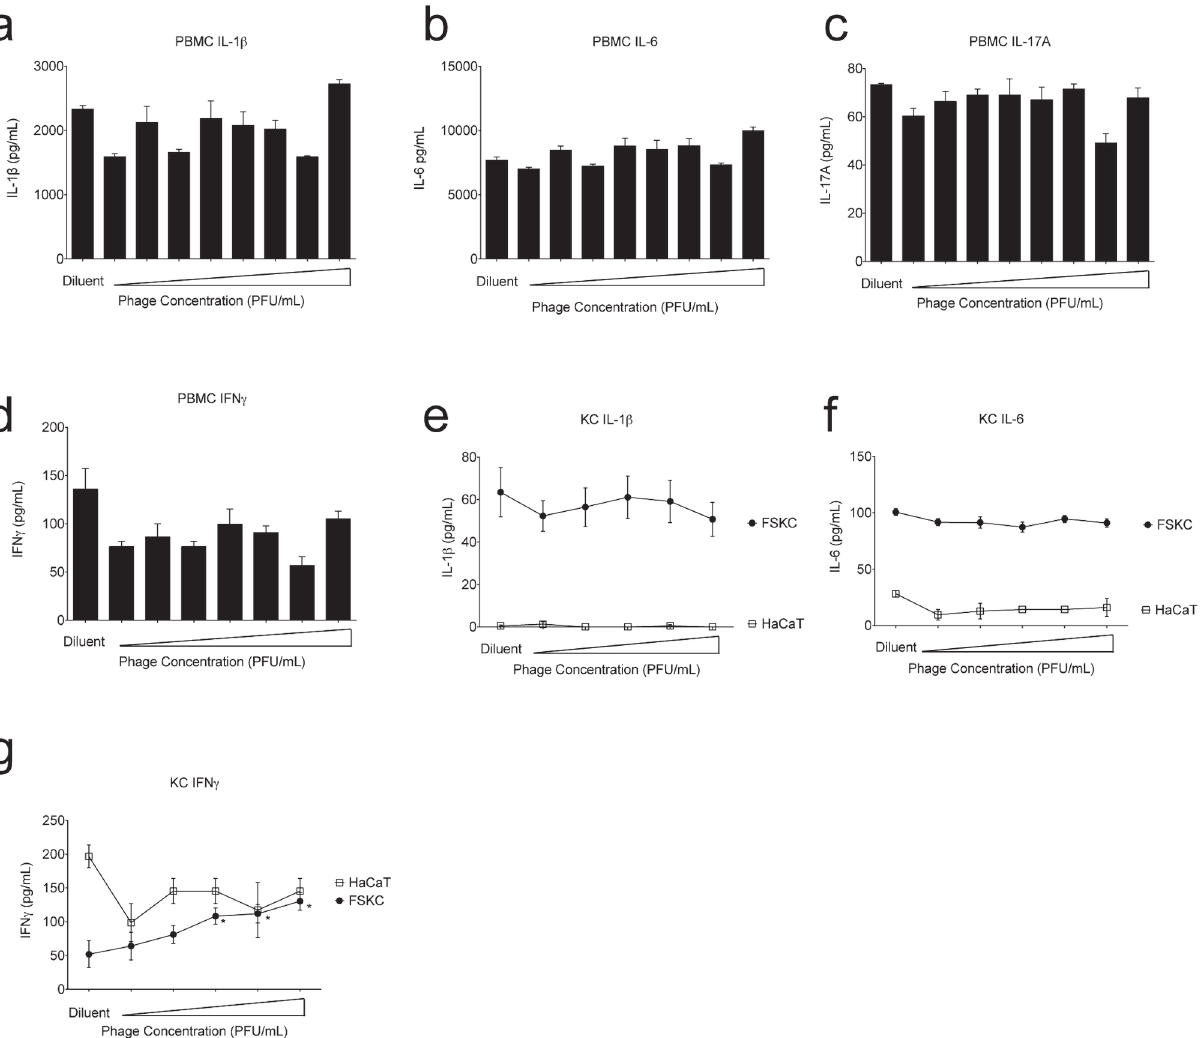
Fig 4. SATA-8505 Induces Interferon Gamma in Primary Human Keratinocytes. Human peripheral mononuclear cells (PBMC) were cultured in triplicate at 2 6 /mL with SATA-8505 at 1 PFU/mL to 10 8 PFU/mL at ten-fold increments or diluent derived from the supernatant of an overnight culture of SA that had been pelleted and filter sterilized in a manner similar to the phage-containing media. At 72 hours supernatants were harvested and analyzed for IL-1ß (a), IL-6 (b), IL-17A (c), and IFN gamma (d). Human keratinocytes from primary foreskins (foreskin keratinocytes; FSKC) or the HaCaT cell line were cultured to confluence on 6-well plates and incubated in triplicate with SATA-8505 at 10 4 PFU/mL to 10 8 PFU/mL at ten-fold increments or TSB diluent. At 24 hours supernatants were harvested and analyzed for IL-1ß (e), IL-6 (f), and IFN gamma (g). Phage for all experiments was diluted in TSB from overnight culture of USA300 that was centrifuged at 5000rpm for 12 minutes and filter-sterilized through a 0.44 micrometer filter. Data shown are representative of 3 independent experiments using 3 different healthy volunteers (a-d) or a pool of 5 or more foreskin samples (e-g) and displayed as mean + s.e.m. * = p < 0.05.